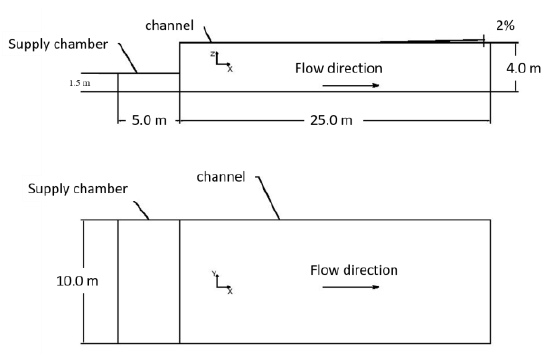
Fig. 2. : Sketch presents the numerical channel.